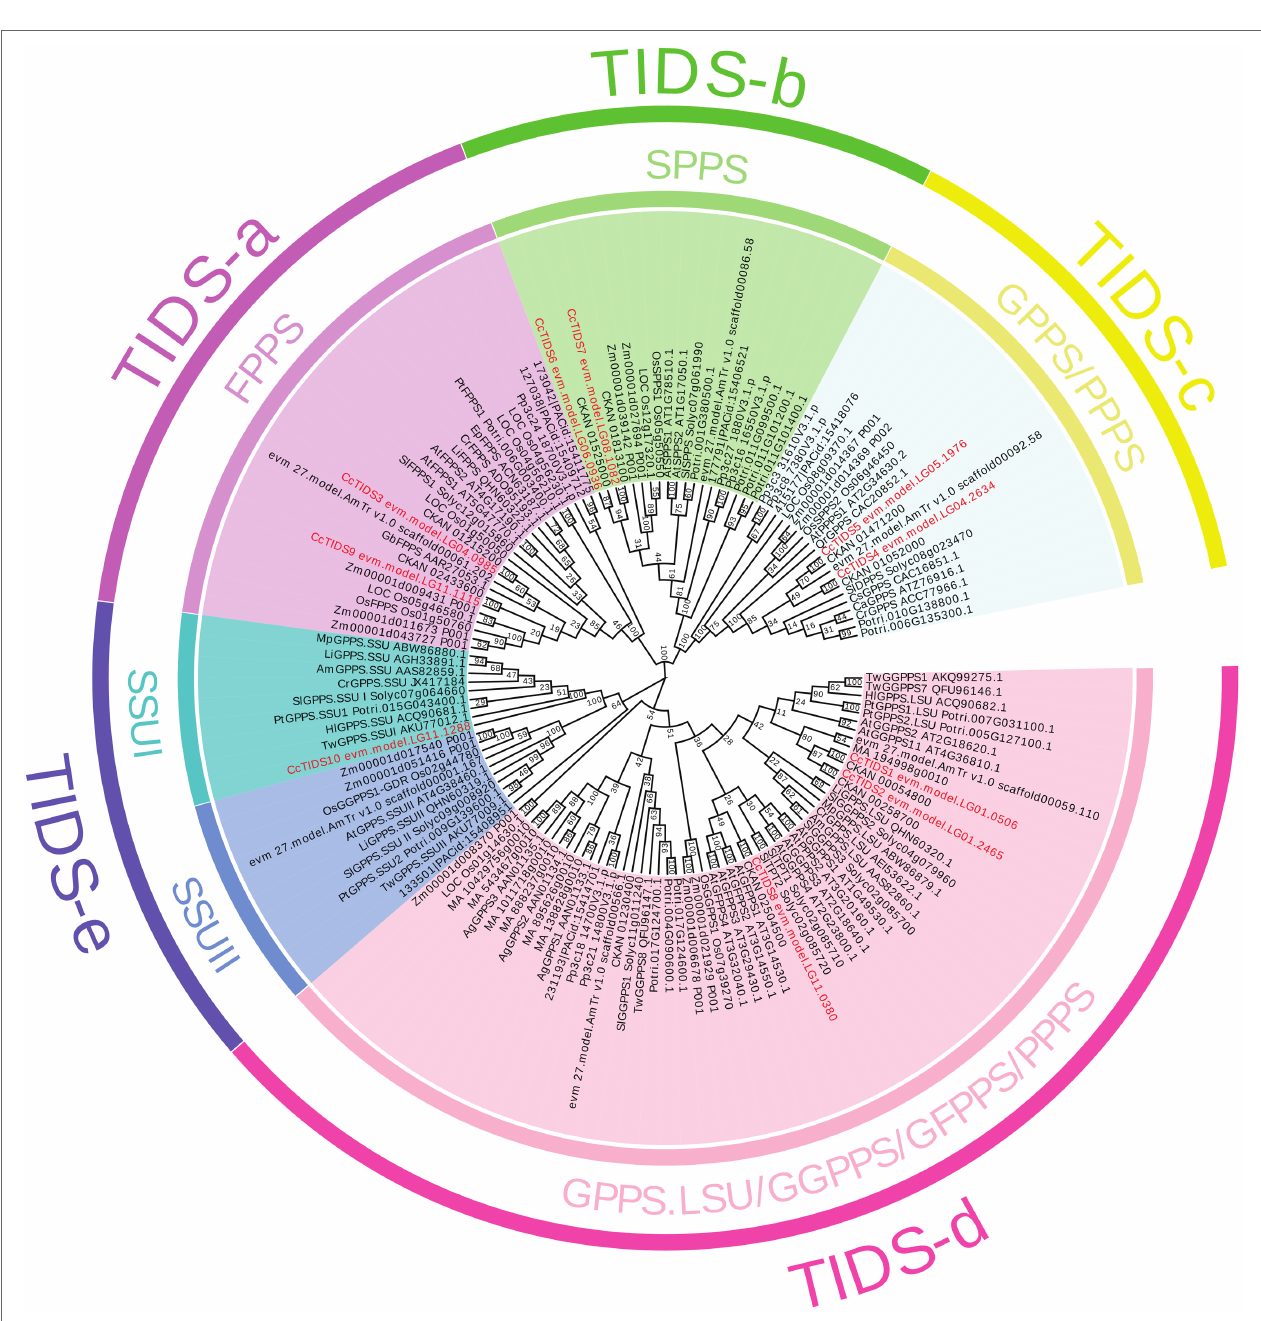
FIGURE 2 | A phylogenetic tree constructed using putative or characterized TIDS genes from 11 sequenced land plant genomes and a neighbor joining approach. GPPS, geranyl diphosphate synthase; FPPS, farnesyl diphosphate synthase; GGPPS, geranylgeranyl diphosphate synthase; LSU, large subunit; SSUI/II, small subunit I/II; GFPPS, geranylfarnesyl diphosphate synthase; PPPS, polyprenyl diphosphate synthase; and SPPS, solanesyl diphosphate